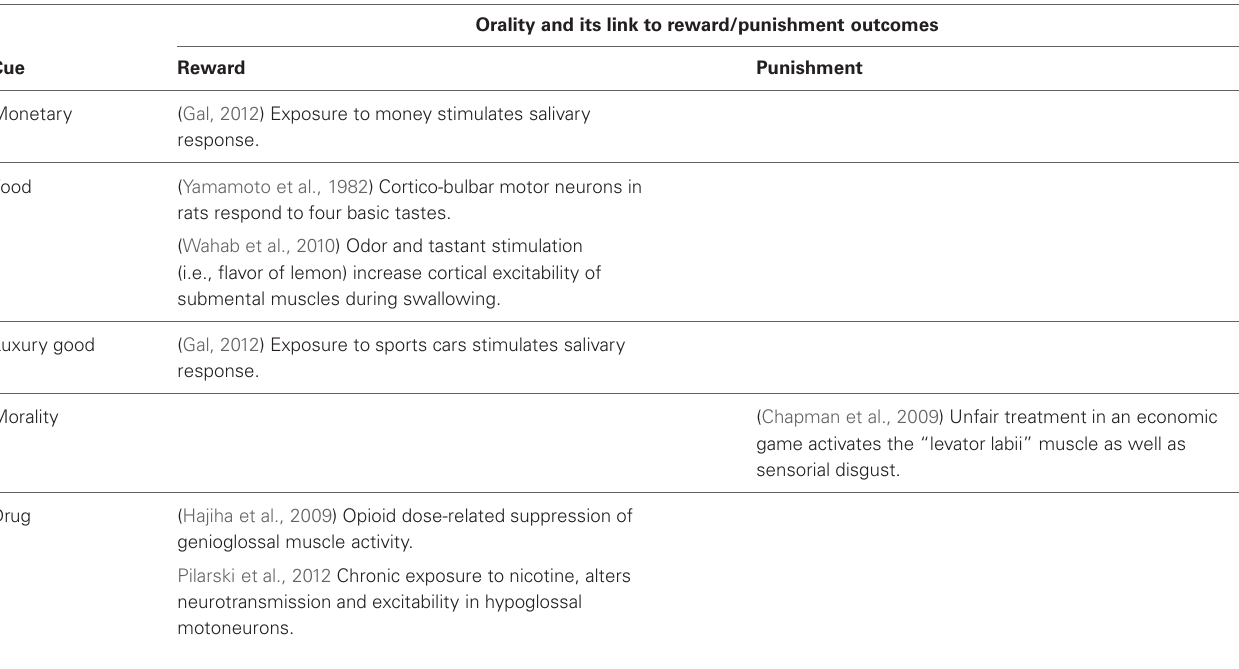
Table 1 | Experimental evidence in support of relation between cortico-bulbar excitability and reward/punishment outcomes. Orality and its link to reward/punishment